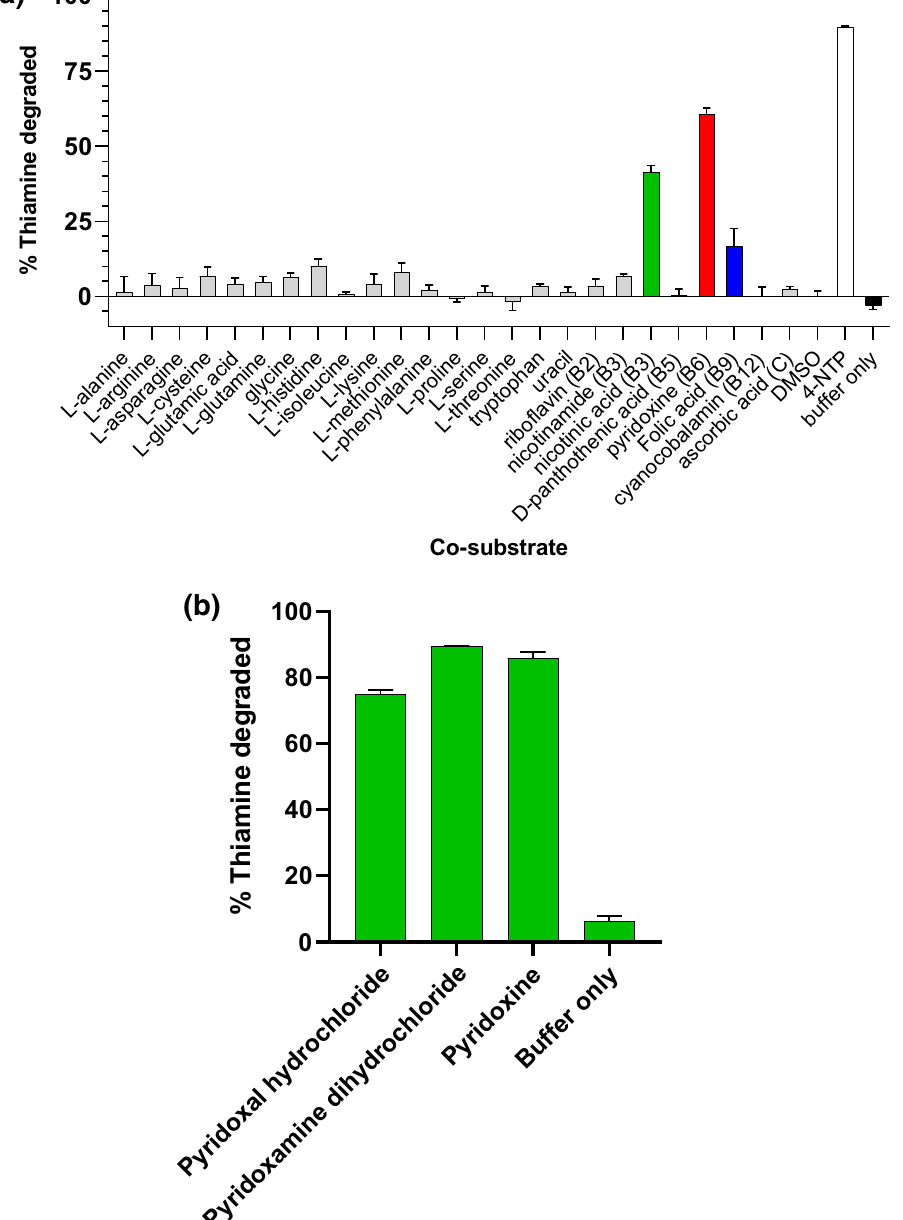
Figure 2. Screening for natural co-substrates for thiaminase I from C. botulinum ( a ) amino acids and vitamins and ( b ) congeners of vitamin B6 . 10 µM thiamine, 1 mM co-substrate in 20 mM MES/20 mM NaCl, pH 6.5 were incubated in the presence and absence of 0.5 µg/mL thiaminase I at 37 °C for 1 h. 5 µL of the reaction mixture was diluted with 45 µL water, then 100 µL alkaline potassium ferricyanide was added prior to measurement using 360/40 nm excitation, 450/50 nm emission. 4-NTP was used as a positive control as a known effective